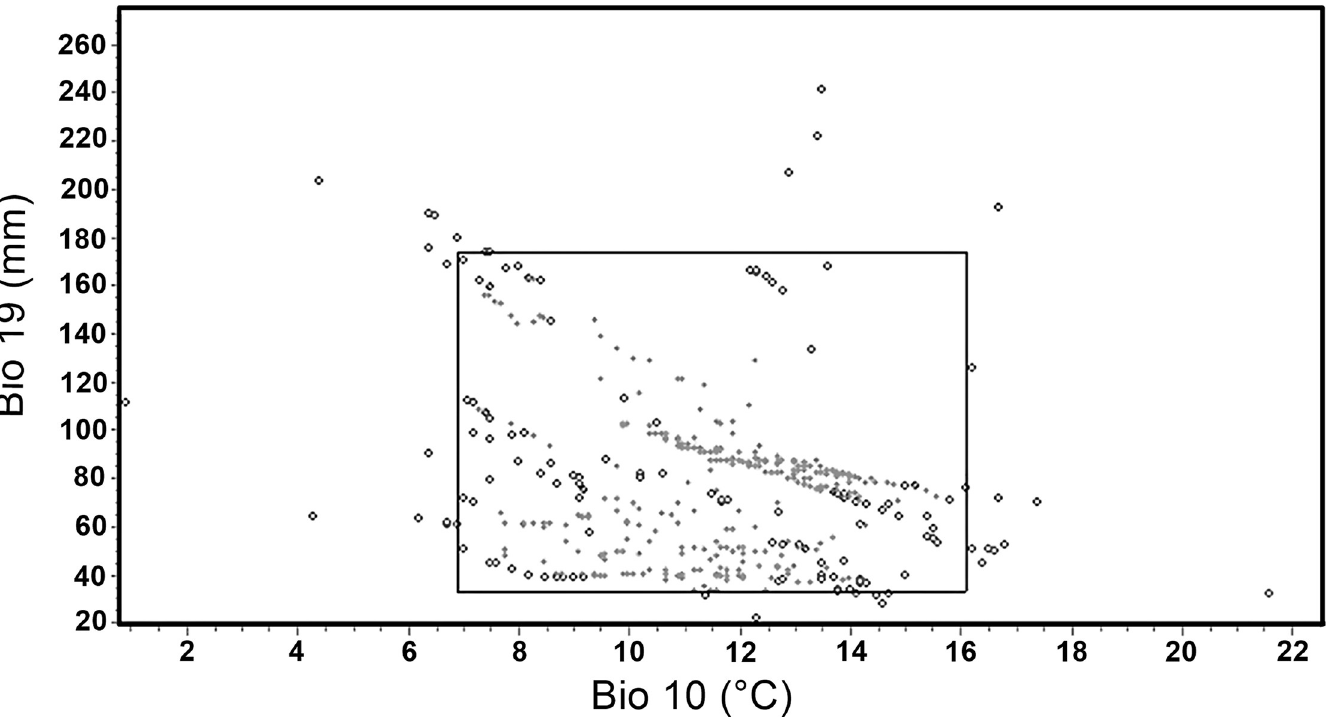
Fig 5. Niche breadth of P . hartwegii represented with two bioclimatic variables that provides the most information according to Jackknife analysis: The temperature of the warmest quarter (Bio10) and the precipitation of the coldest quarter (Bio19).